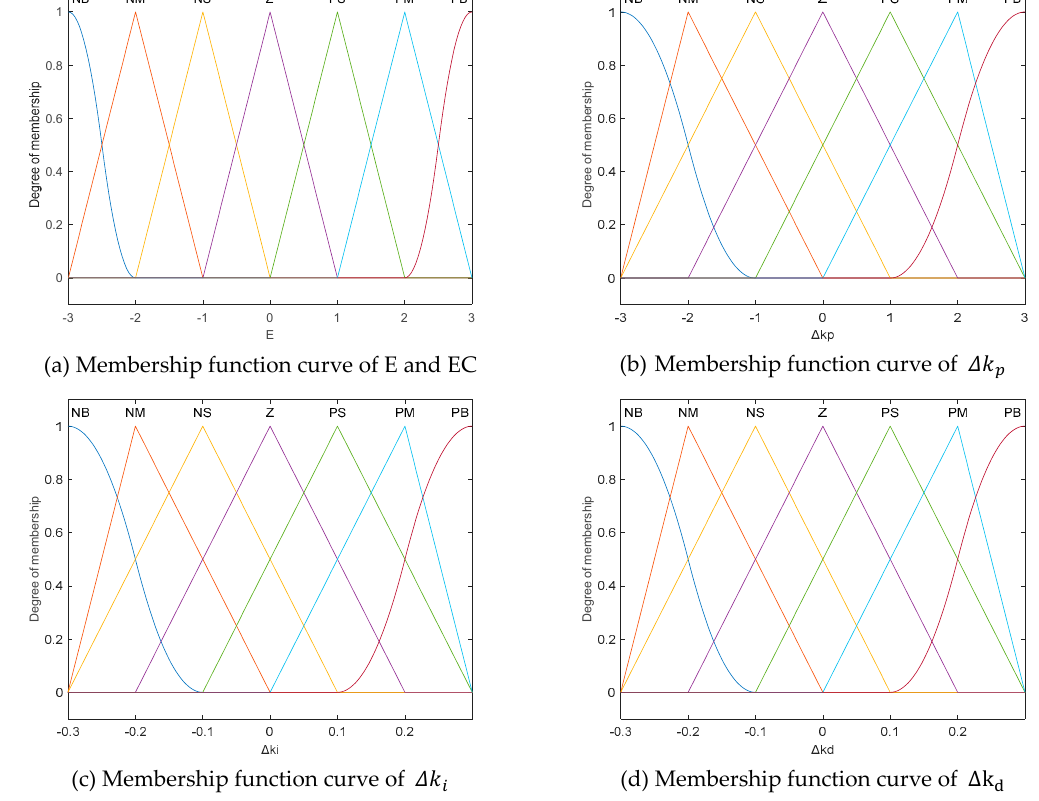
Figure 4. Membership function curve of input and output variables